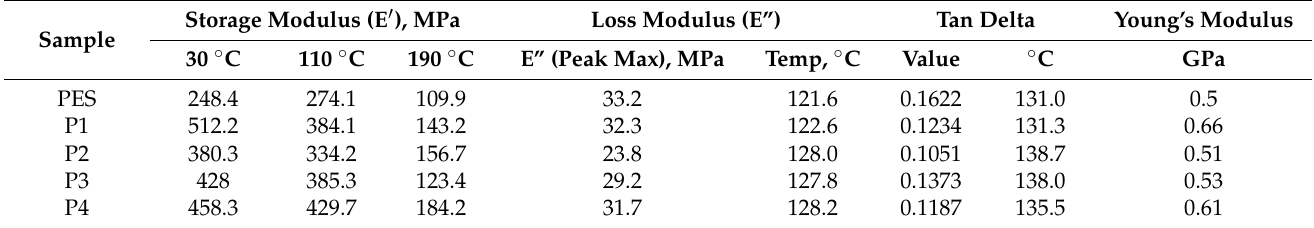
Figure 8. The thermomechanical properties of coated polyester fabrics, subjected to deformation forces ( a , b ), stress ( c , d ) vs. temperature. Table 2. Storage modulus at 30 ◦ C, 110 ◦ C and 190 ◦ C, loss modulus, tan delta and Young’s